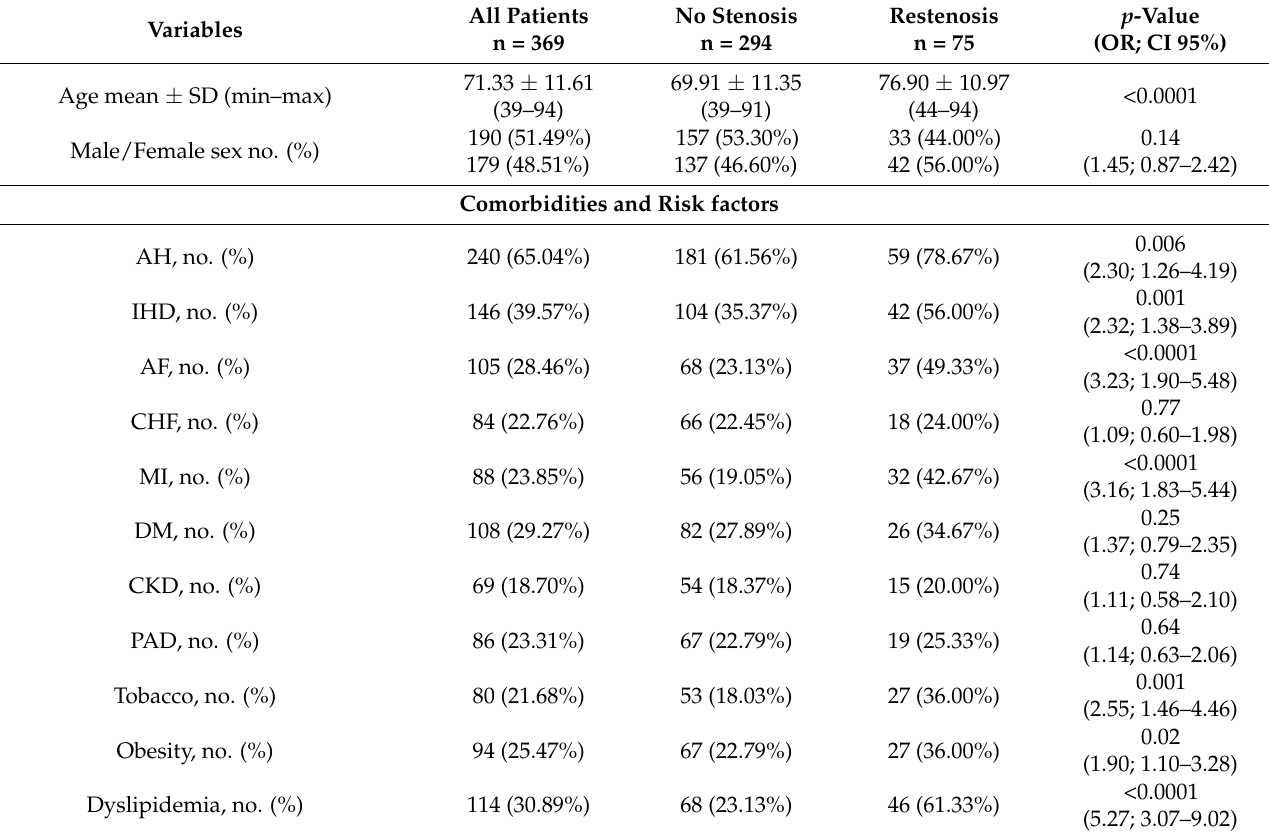
Table 1. The baseline characteristic data of all patients and divided according to the restenosis risk at 24